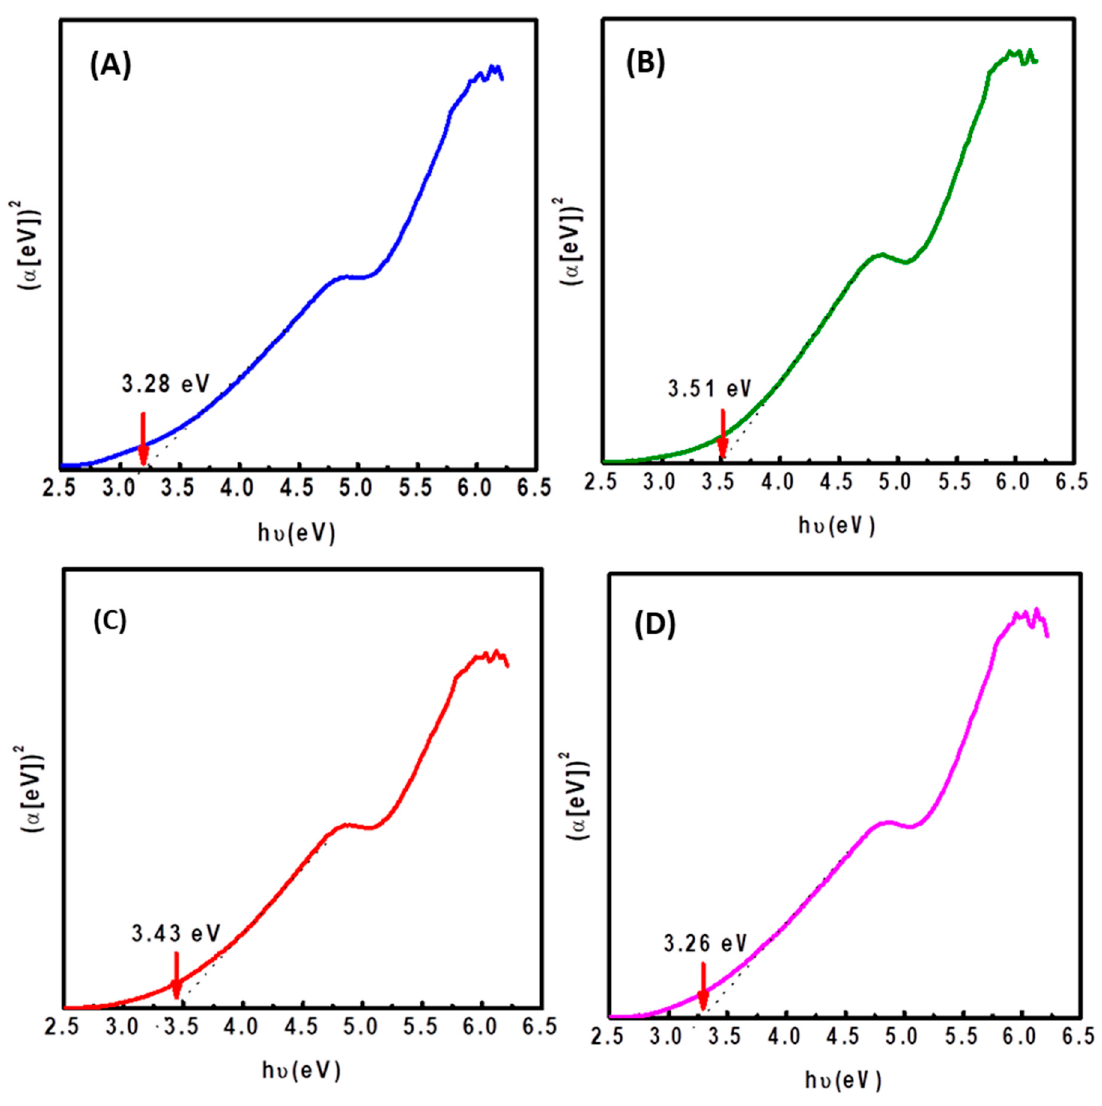
Figure 8. Plot of ( α h υ ) 2 vs. photon energy (h υ ) for calcined NiMoW/Al-Ce( x ) catalysts: ( A ), Ni- Figure 8 . Plot of ( α h υ ) 2 vs. photon energy (h υ ) for calcined NiMoW/Al ‐ Ce( x ) catalysts: ( A ), Ni ‐ MoW/Al; ( B ), NiMoW/Al-Ce5; ( C ), NiMoW/Al-Ce10, and ( D ), MoW/Al; ( B ), NiMoW/Al ‐ Ce5; ( C ), NiMoW/Al ‐ Ce10, and ( D ), NiMoW/Al ‐ Ce15.